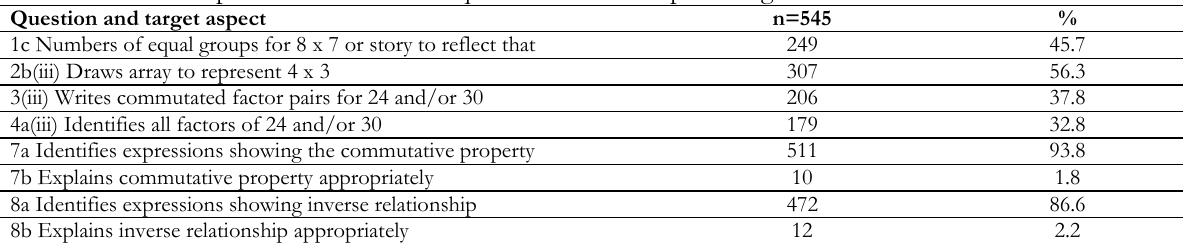
Table 2. Correct responses to the selected questions shown as percentages